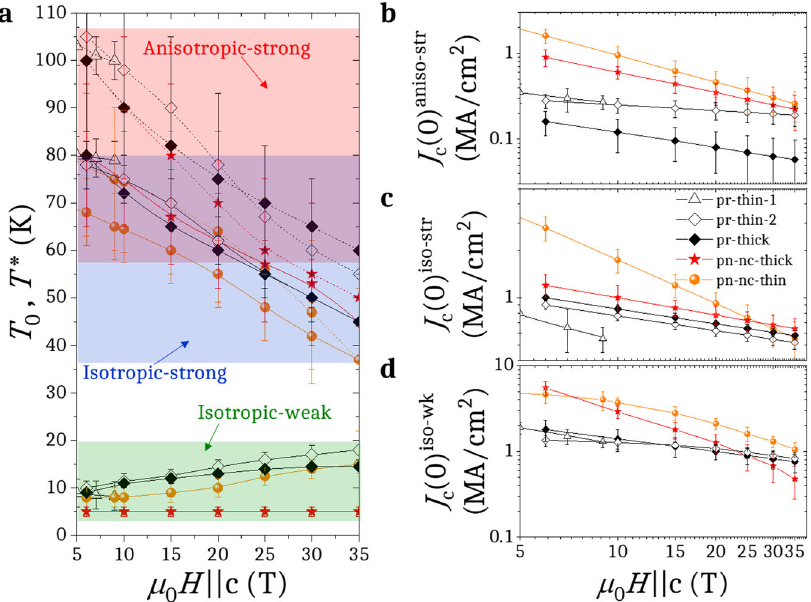
Fig. 7 Characteristic temperatures, density and strength of pinning centres at very high magnetic fi elds. Magnetic fi eld dependence of characteristic temperatures ( a ) T 0 (solid lines), T * iso-str (solid lines) and T * aniso-str (dashed lines), and J c contributions at 0 K ( b ) J c aniso-str , ( c ) J c iso-str and ( d ) J c iso-wk for pr-thin-1, pr-thin-2, pr-thick, pn-nc-thin and pn-nc-thick samples for H | | c at very high magnetic fi elds. Error bars are determined by the standard error of the parameters from the fi tting of Eq.